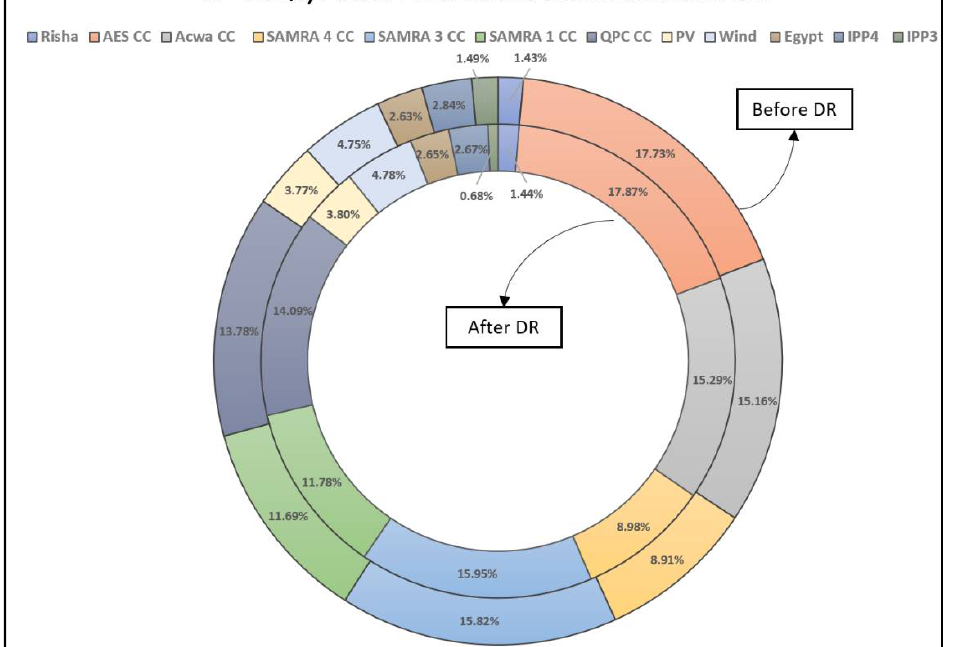
Figure 24. Power plant shares for the Case of C7-300% before and after DR.